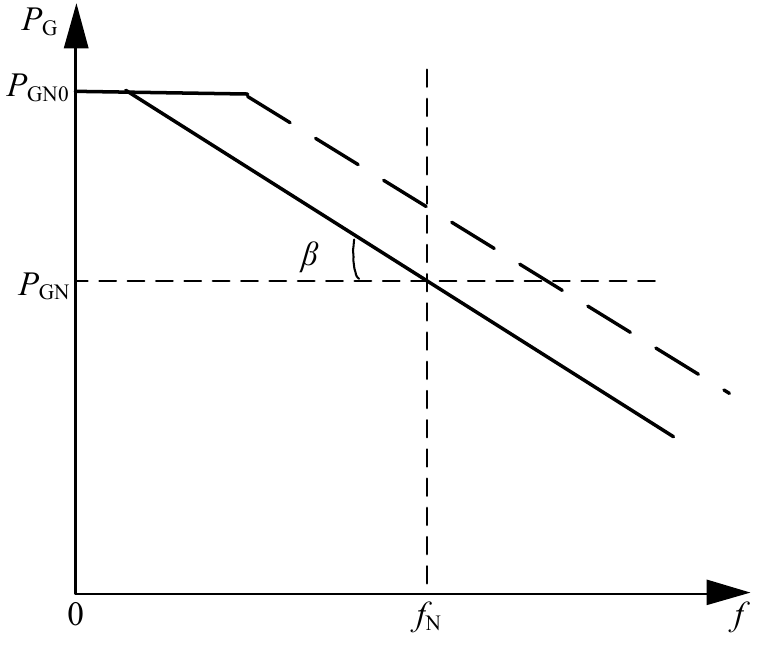
Figure 4. Power-frequency static characteristics of the generator.